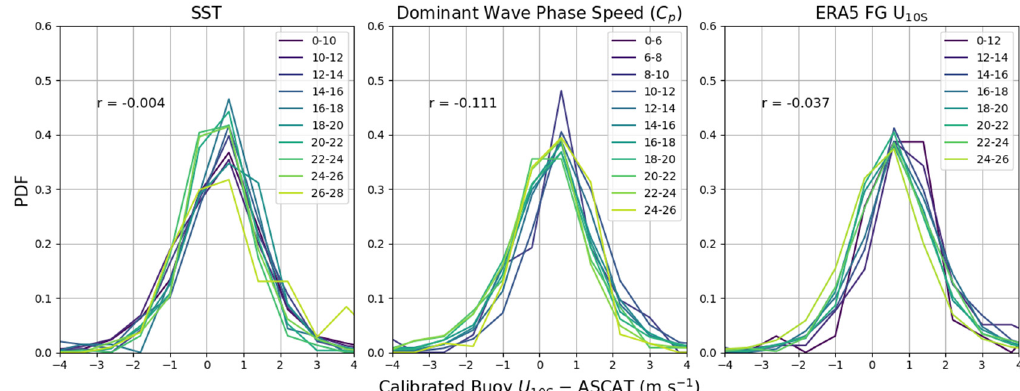
Figure 10. Probability density functions of wind speed residuals (calibrated buoy U 10 S –ASCAT) binned by ERA5 H s between 4 and 6 m and SST (left), c p (center), and ERA FG U 10 S (right) ranges colored by value bins in the figure legends. The Pearson correlation coefficient ( r ) between wind speed residuals and the variable in question is shown in the top left of each plot.